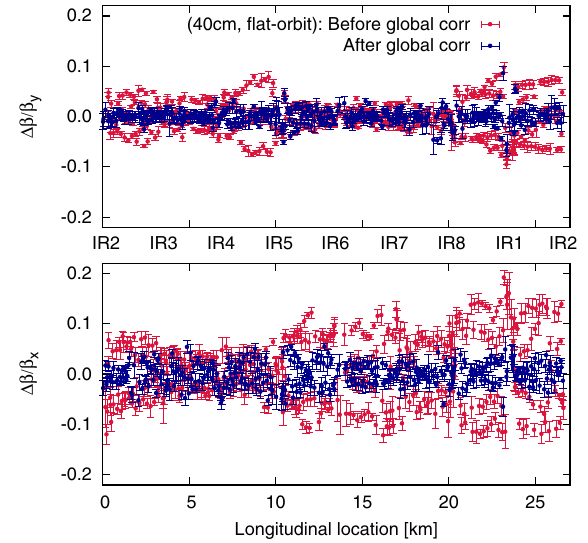
FIG. 2. β -beat in LHC Beam 1 before and after application of global optics correction at flat orbit in